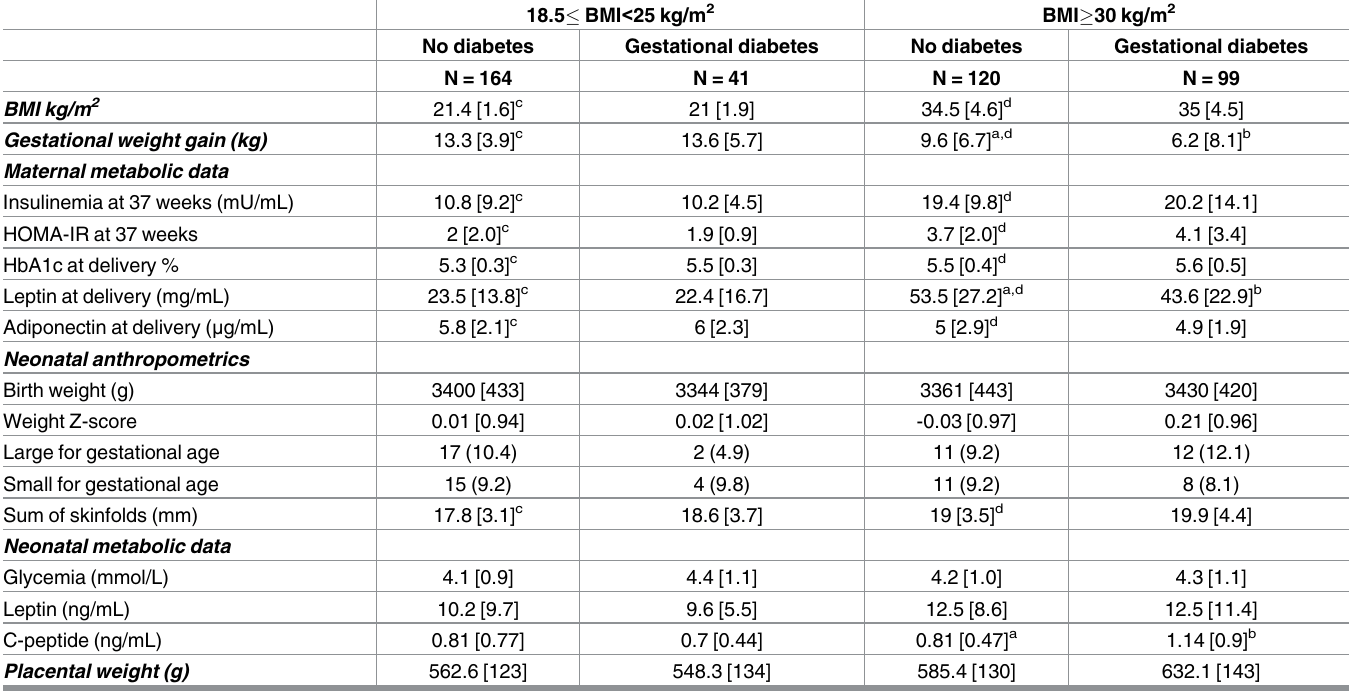
A comparison was performed within the Ob group between non-diabetic obese women and diabetic obese women. Obese women with diabetes gained less weight during pregnancy and had lower serum leptin concentrations at delivery (p < 0.05 for both criteria). The only signifi- cant difference between neonates in these two groups was that cord serum C-peptide concen- trations were significantly higher in diabetic women (p < 0.05). Table 2. Maternal and neonatal characteristics according to maternal BMI and to diabetic status. Obese non-diabetic women were compared to obesediabetic women (a and b superscripts) and to non-obesenon-diabetic women (c and d superscripts). Data are expressedas mean [SD] or N